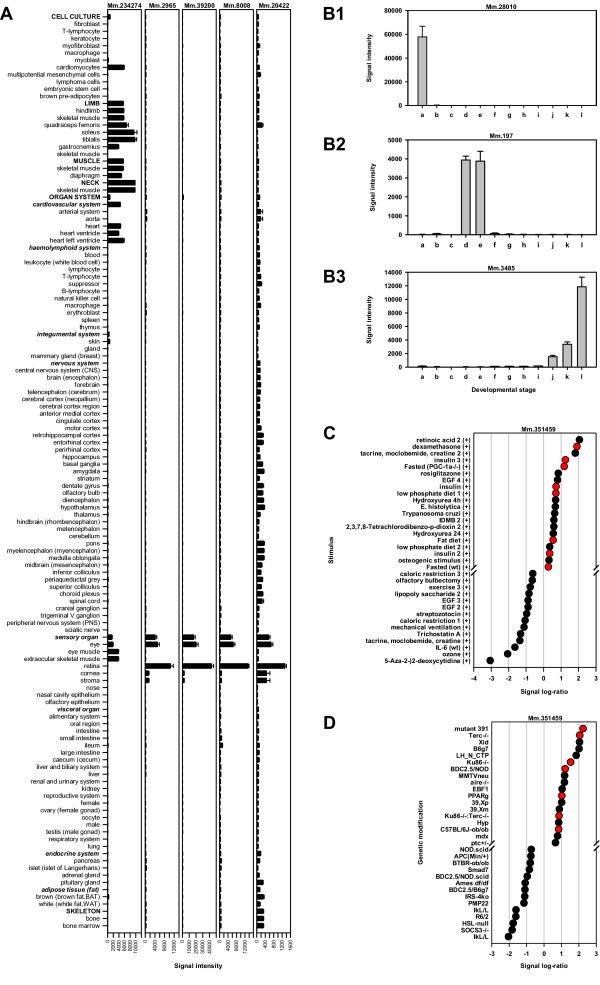
Validation of expression profiles. The results shown were calculated from 2138 arrays of type MG-U74Av2 (12 K). Similar results can be obtained using arrays of type Mouse430 2.0 (40 K) for categories available in both array types. For each gene, the signal intensity value indicated in each category is the average signal intensity value (of the corresponding probe set) from all arrays within this category. Average signal intensity values are available throughout all shown categories for all probe sets represented on the 12 K array. A. Anatomy expression profiles of genes shown in the literature to be preferentially expressed in muscle and heart (Mm.234274) or in retina (Mm.2965, Mm.39200, Mm.8008, Mm.20422). B1-B3. Development expression profiles of three genes previously shown to be expressed in oocytes and up to the 8-cell stage (Mm.28010), between E7.5 and E8.5 (Mm.197), and in adult mouse but low in embryo or newborn mice (Mm.3485). Developmental stages are defined as pre-natal (given in Theiler stages (TS); a: TS-1 to 2, b: TS-3 to 5, c: TS-6 to 9, d: TS-10 to 13, e: TS-14 to 18, f: TS-19 to 23, g: TS-24 to 27) or post-natal (given in days after birth; h: 0–3, i: 4–15, j: 16–63, k: 64–255, l: > 256). C and D. Response of Sirt1 (Mm.351459) to a set of stimuli (C) and to genetic modifications (D). Only treatments or mutations inducing strong up or down regulation are shown. Effects described in the text are highlighted. These precompiled responses are log-ratios from the average signal intensity values of treatment versus control samples from a variety of experiments and tissues.